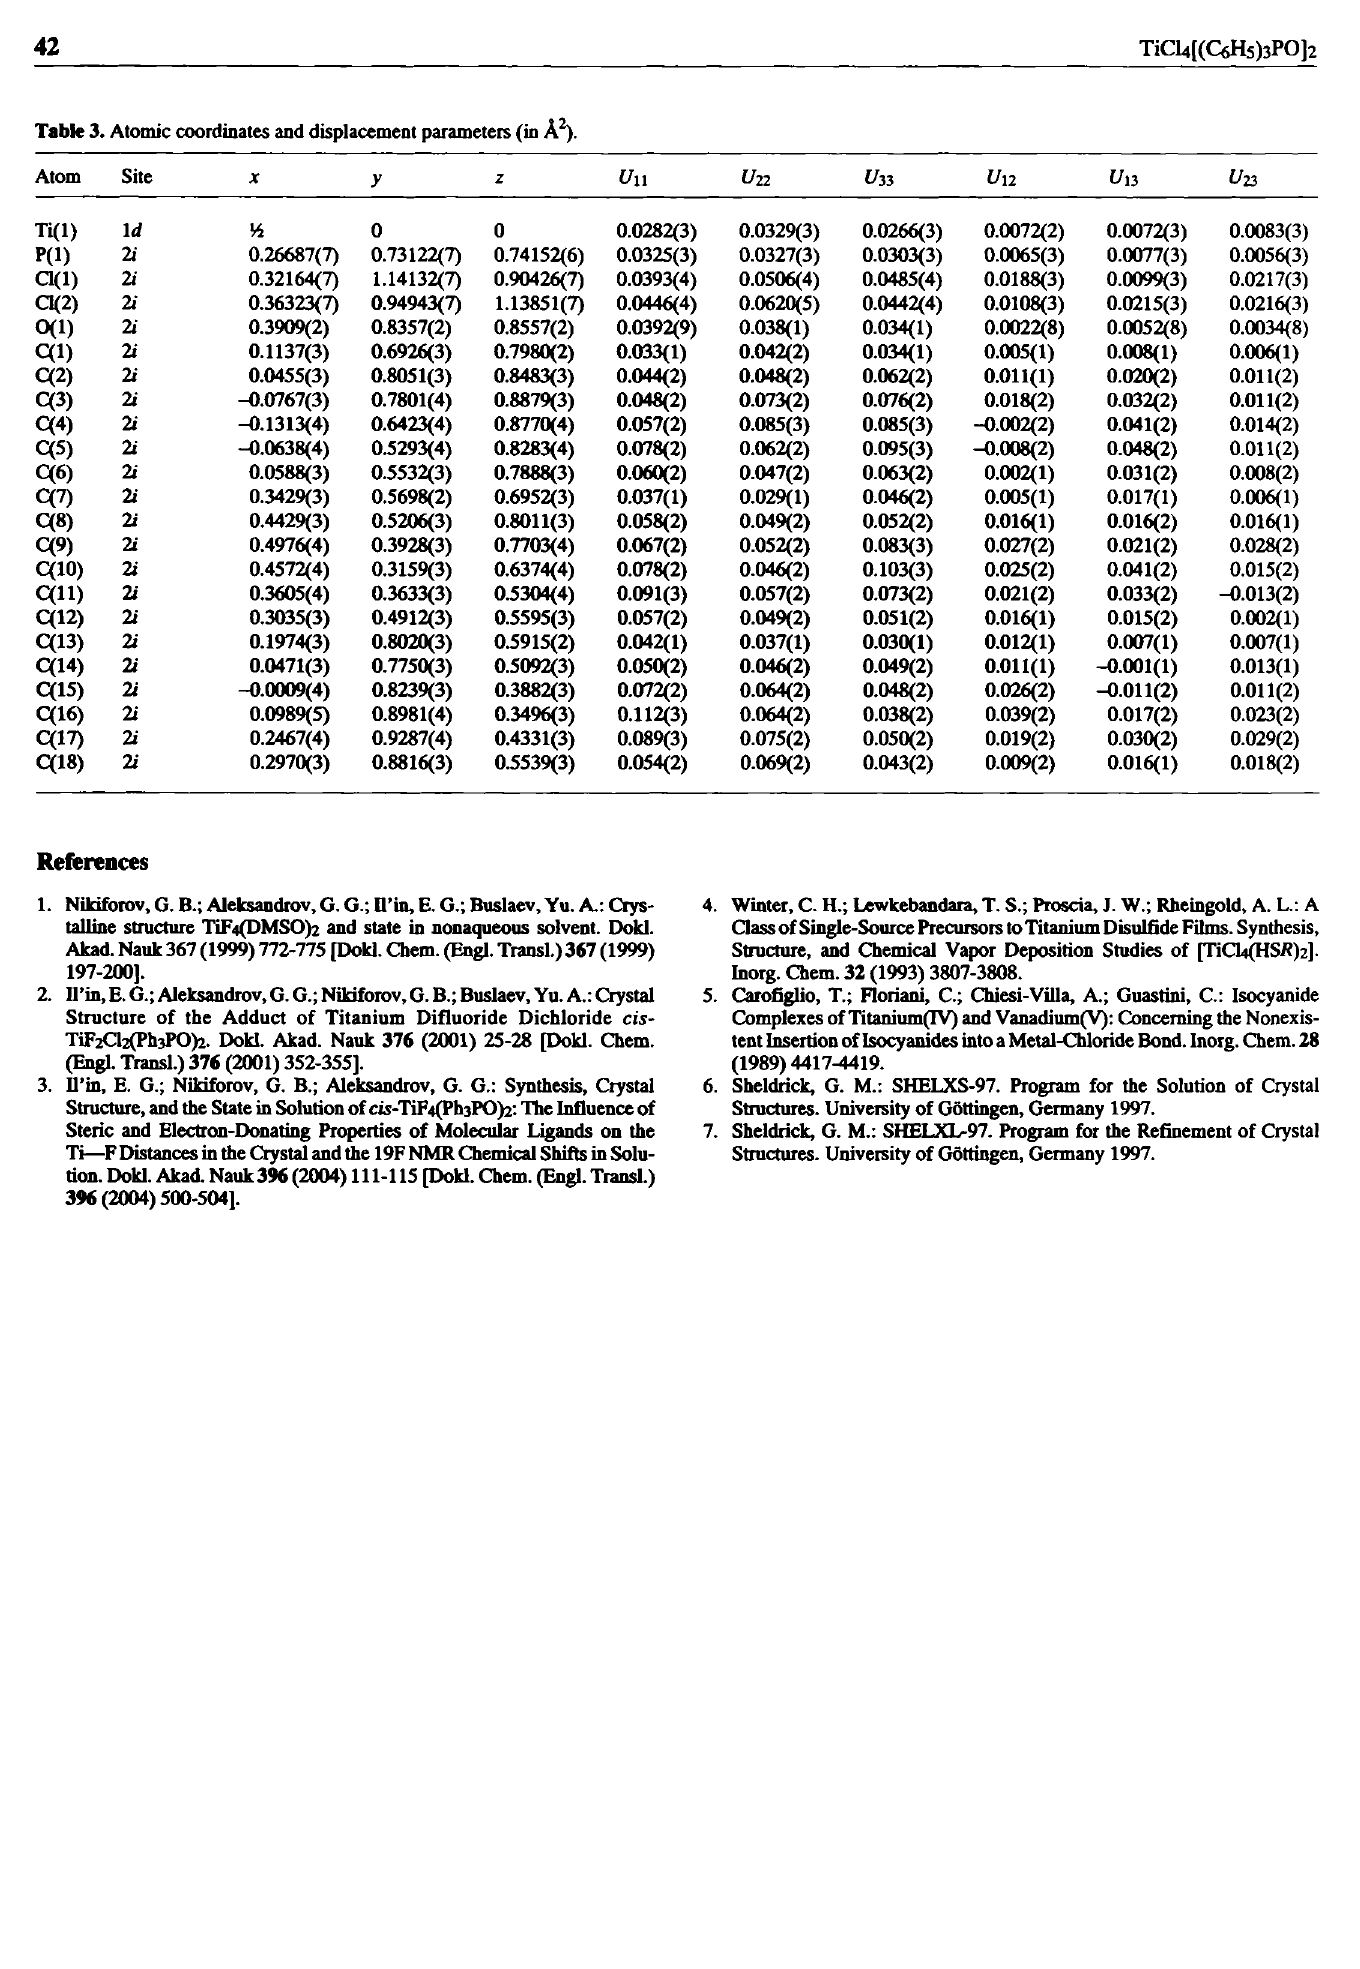
Table 3. Atomic coordinates and displacement parameters (in Ä 2